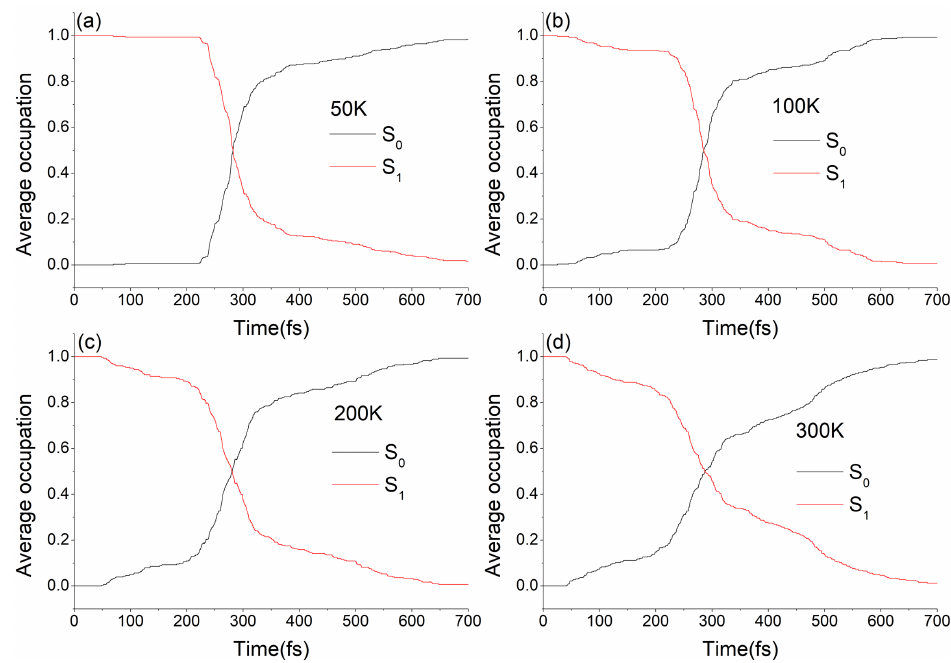
Figure 7. Average occupation of the electronic states S 0 and S 1 as a function of simulation time in